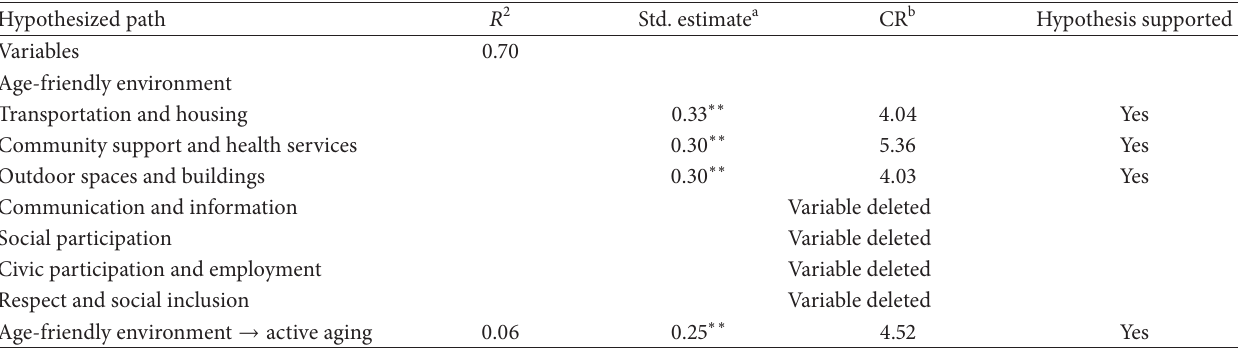
Table 6: Results of hypotheses testing.